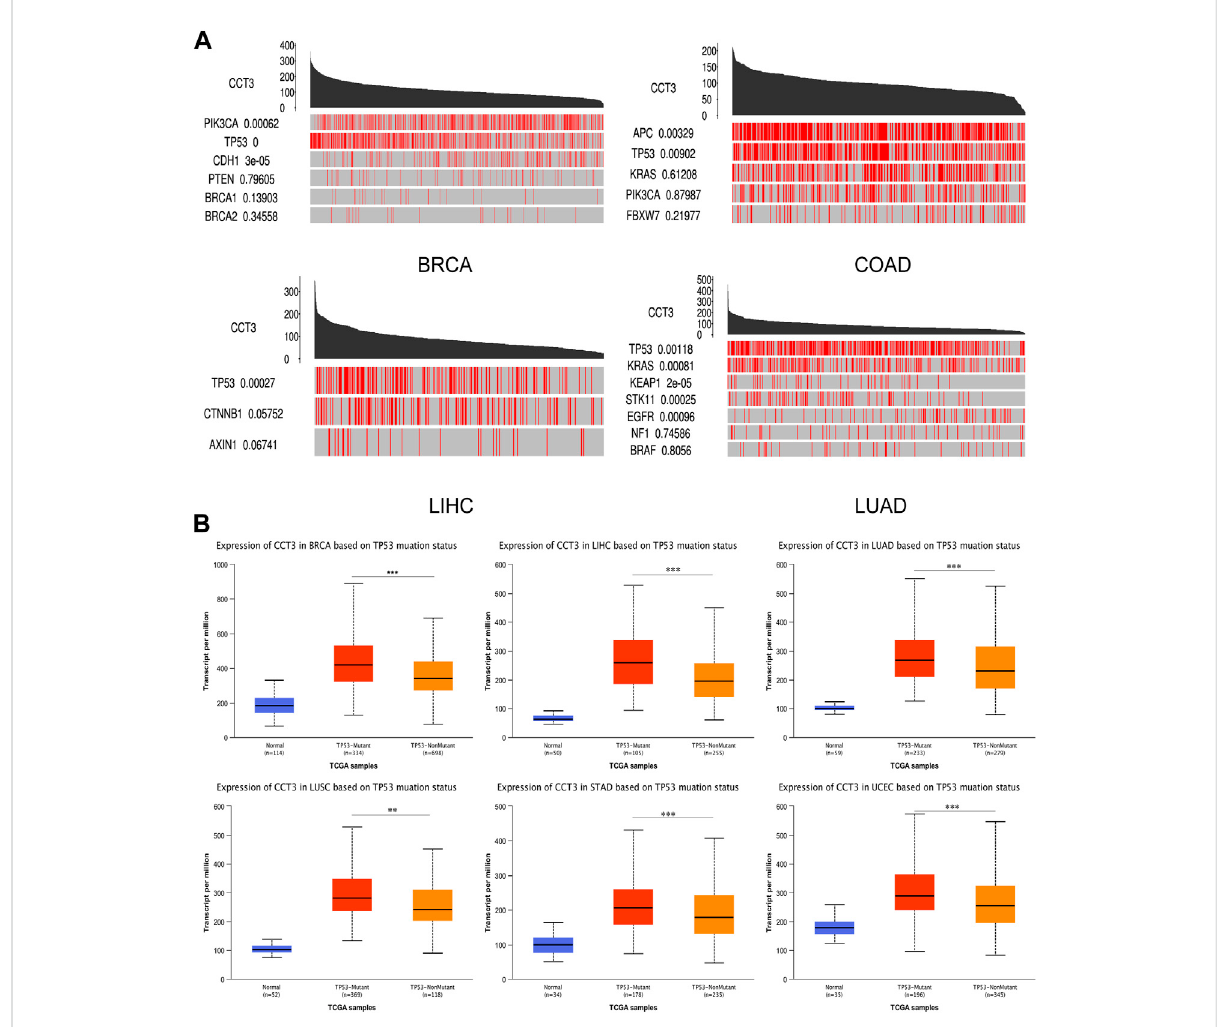
The effect of driver genes on CCT3 expression. (A) The correlation between CCT3 expression and driver genes in four cancers (BRCA, COAD, LIHC, LUAD) was analyzed using the TCGA portal database. (B) The correlation between CCT3 expression and TP53 mutation status was analyzed using the UALCAN database. * p < 0.05, ** p < 0.01, *** p <